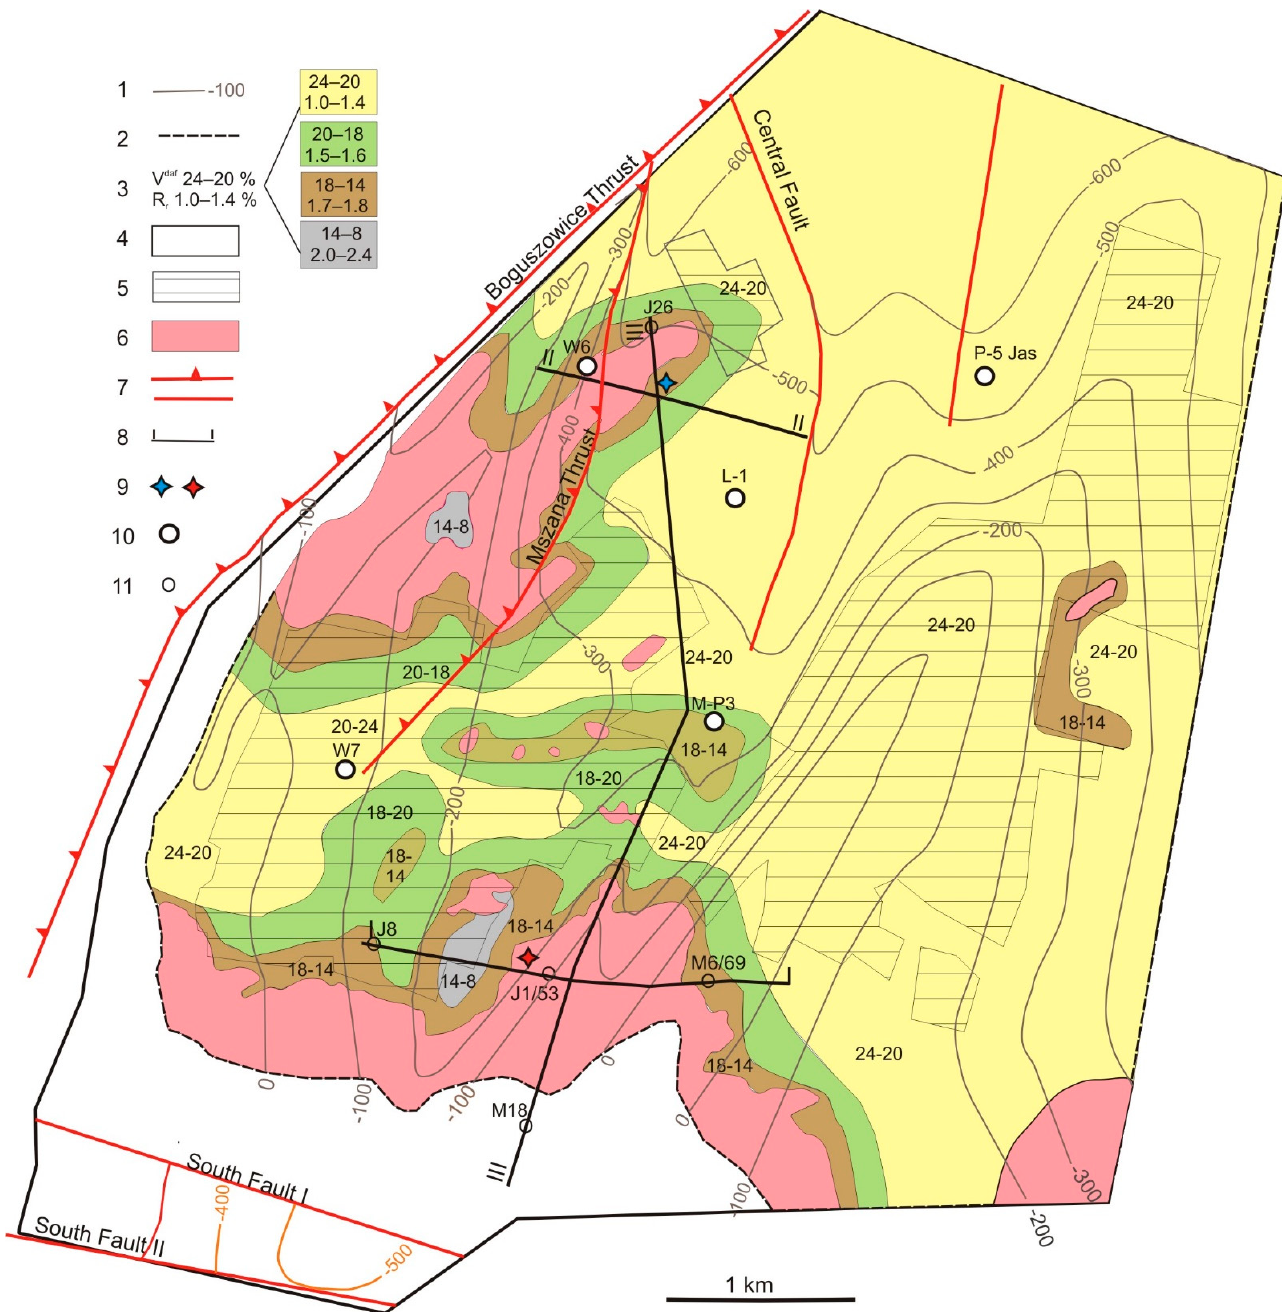
Figure 2. Structural sketch map of the coal seam No. 505 in the Jas ‐ Mos mining area, a part of the Jastrz ę bie ‐ Bzie Coal Mine, and its disappearance (based on geological documentation of Jastrz ę bie ‐ Bzie Coal Mine, simplified). 1: isoline of the bottom of coal seam No 505 in m a.s.l.; 2: subcrop of 505 coal seam below Miocene claystone; 3: coal rank and quality—isolines of the average volatile matter content (V daf %), vitrinite reflectance R r % and coal types; 4: unexploited coalfield, 5: exploited coal; 6: altered associated gangue rocks and vanishing coal seam 505; 7: fault and thrust; 8: geological cross ‐ section lines; 9: outcrops of coal seam 505 in testing gallery 47 (samples N1–8 in blue) and in south corridor II below coal seam 418 (samples S1–6 in red); 10: shaft; 11: drilling.